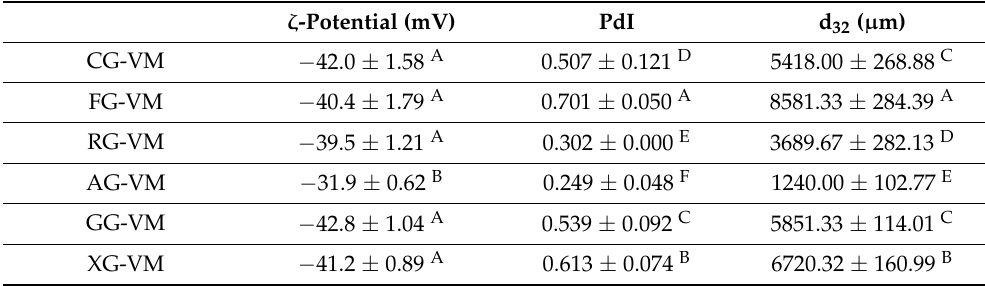
Table 7. The zeta potential and particle size of vegan mayonnaise samples with a different type of gum.